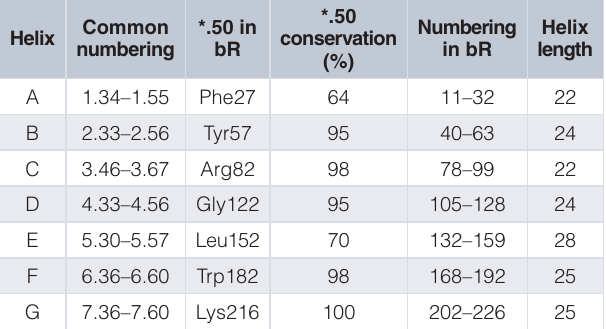
Table 2. The crystallographic models used for set 3 in the present study.